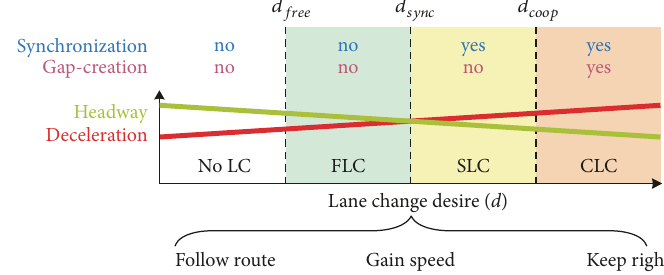
Figure 2: Four types of lane change behaviors corresponding to the level of lane change desire